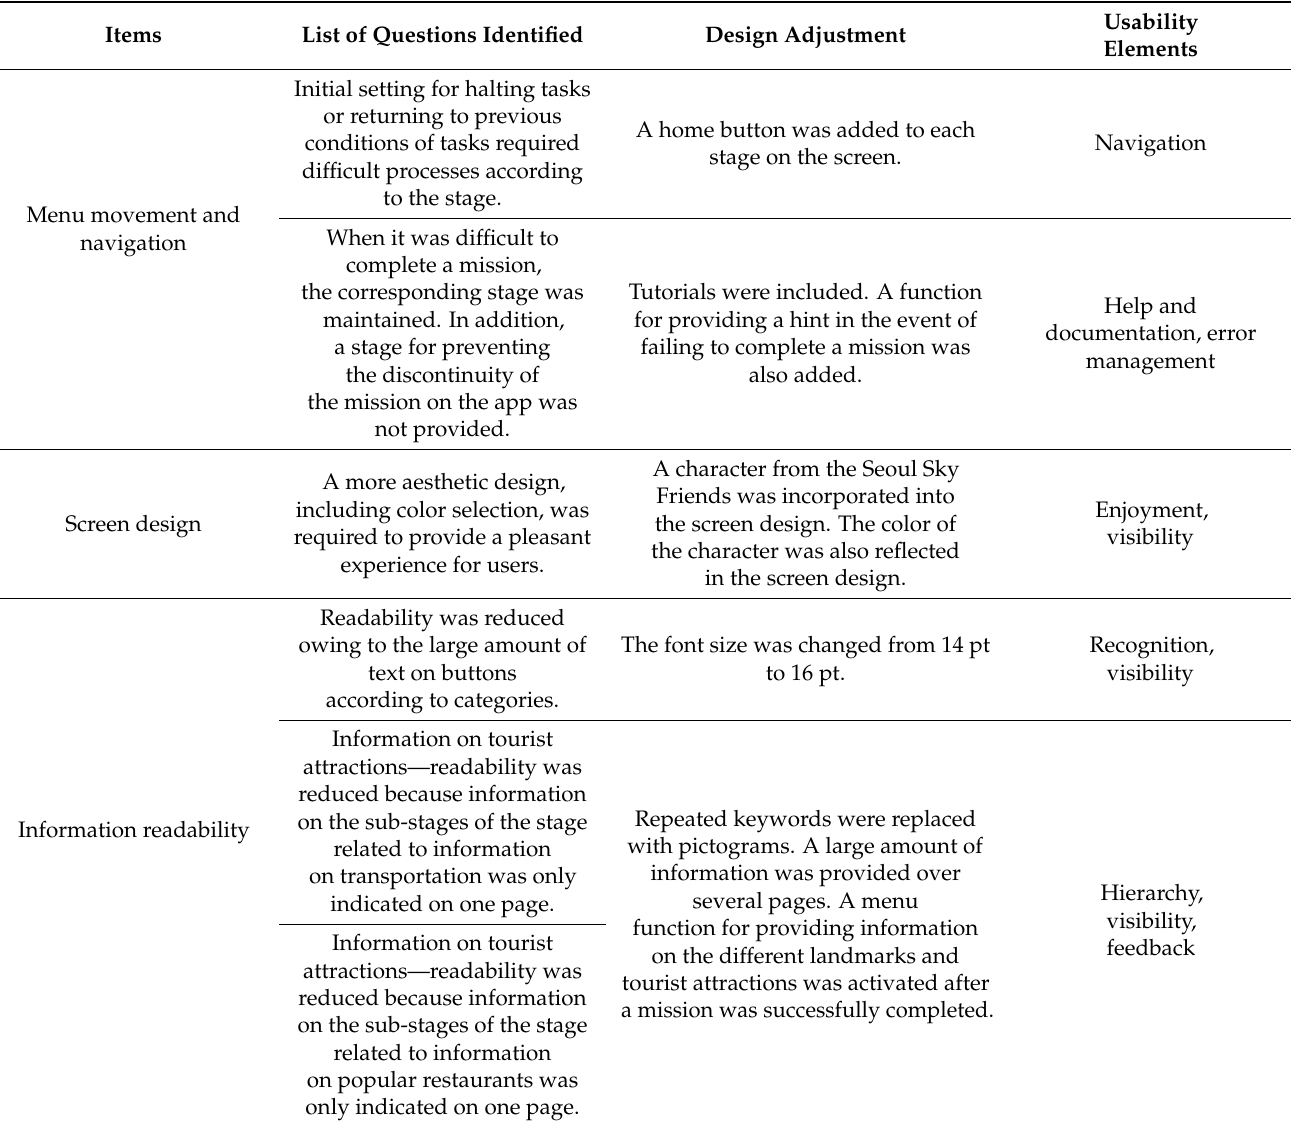
Table 3. Findings from expert reviews of the early prototype of Seoul